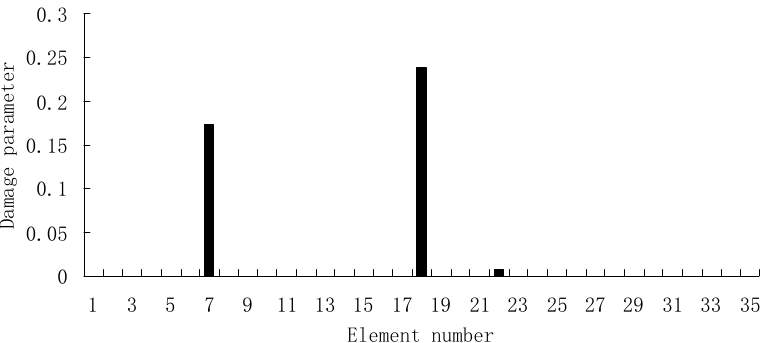
Figure 13. Damage evaluation result by the fourth computation of ESVT for case 2 (elements 7 and 18 had 15% and 20% stiffness reductions).